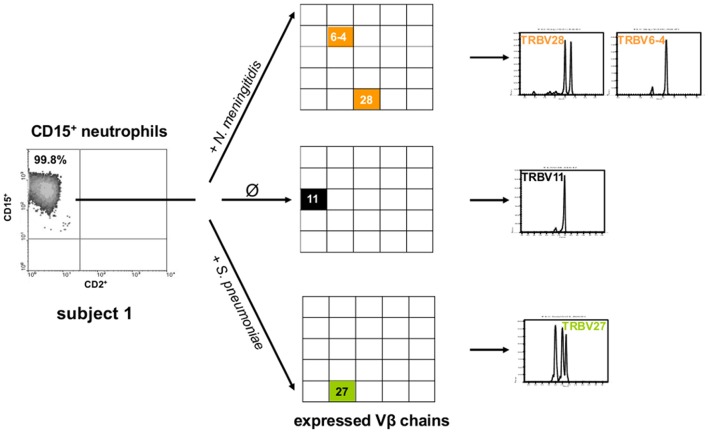
Exposure of neutrophils to bacterial pathogens that cause meningitis induces TCR Vβ repertoire changes in vitro. Shown are the TCR Vβ repertoires that are expressed by peripheral blood CD15+ neutrophils from a healthy subject after 9 h incubation with N. meningitidis (orange), S. pneumoniae (green) and in the absence of a bacterial pathogen, respectively (Ø, control). CD15+ neutrophils were obtained from a single blood draw. The detailed CDR3β length variants are shown in the right panel. The scattergrams (left) document the purity of the CD15+ neutrophils. Note that N. meningitidis and S. pneumoniae induce distinct TCR Vβ chain usage (center) and CDR3β repertoires (right). See also Figure S17.